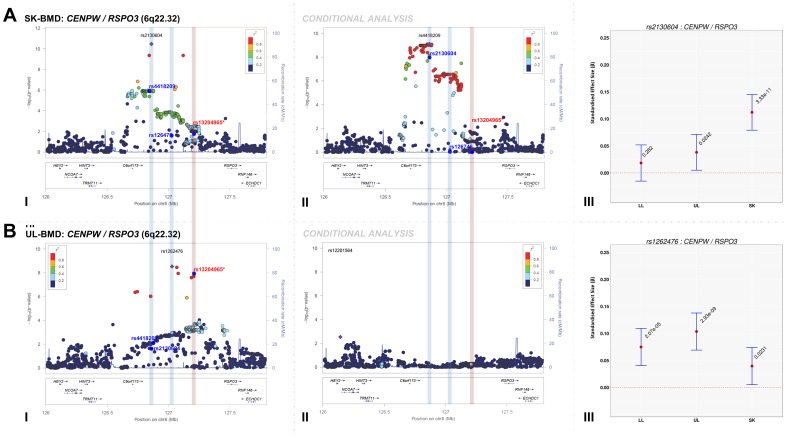
Regional association plots of the top skull- and upper limb-BMD associated SNPs at the 6q22.32 locus before and after conditioning on published SNP (rs13204965*) in addition to a comparison of the effect sizes of the top skull- (rs2130604) and upper limb-BMD (rs1262476) associated SNP (before conditional analysis) on BMD at three different skeletal sites.For I and II: Circles show GWA meta-analysis P-values and positions of SNPs found within each locus. Top SNPs are denoted by diamonds. Different colours indicate varying degrees of pairwise linkage disequilibrium (HapMap 2 CEPH) between the top SNP and all other SNPs. Blue vertical shaded areas indicate the position of rs2130604 (top SNP A-I) and rs1262476 (top SNP B-I) for each analysis. The red vertical shaded area represents the position of the published SNP (rs13204965*). Rsids of relevant SNPs (blue dots) have been provided. For III: The per allele effect in SD (red dot) and 95% confidence intervals (error bar) of each top SNP (before conditional analysis) for lower limb (LL), upper limb (UL) and skull (SK) BMD are plotted with their specific strength of evidence against the null hypothesis of no association. Please note: RSPO3 is also found in the 6q.22.32 locus containing CENPW.